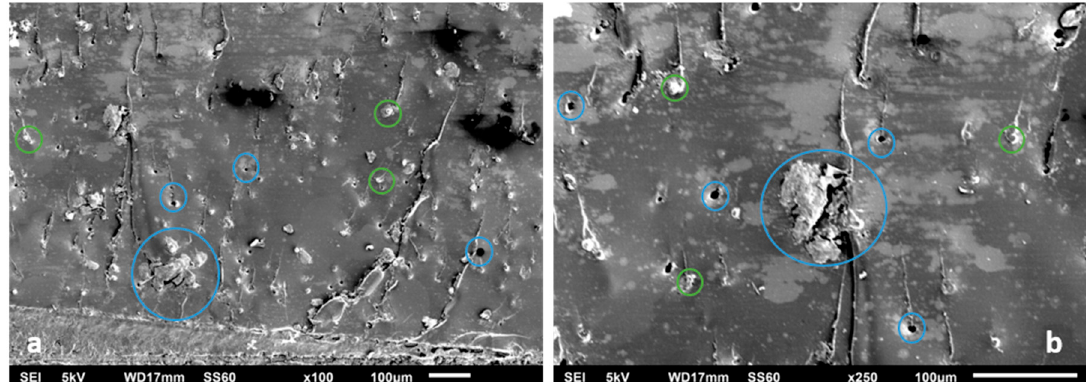
Figure 7. Scanning electron micrographs recorded from the fracture surface of a CB2-IV SENB specimen at ( a ) ×100 and ( b ) ×250 magnifications.